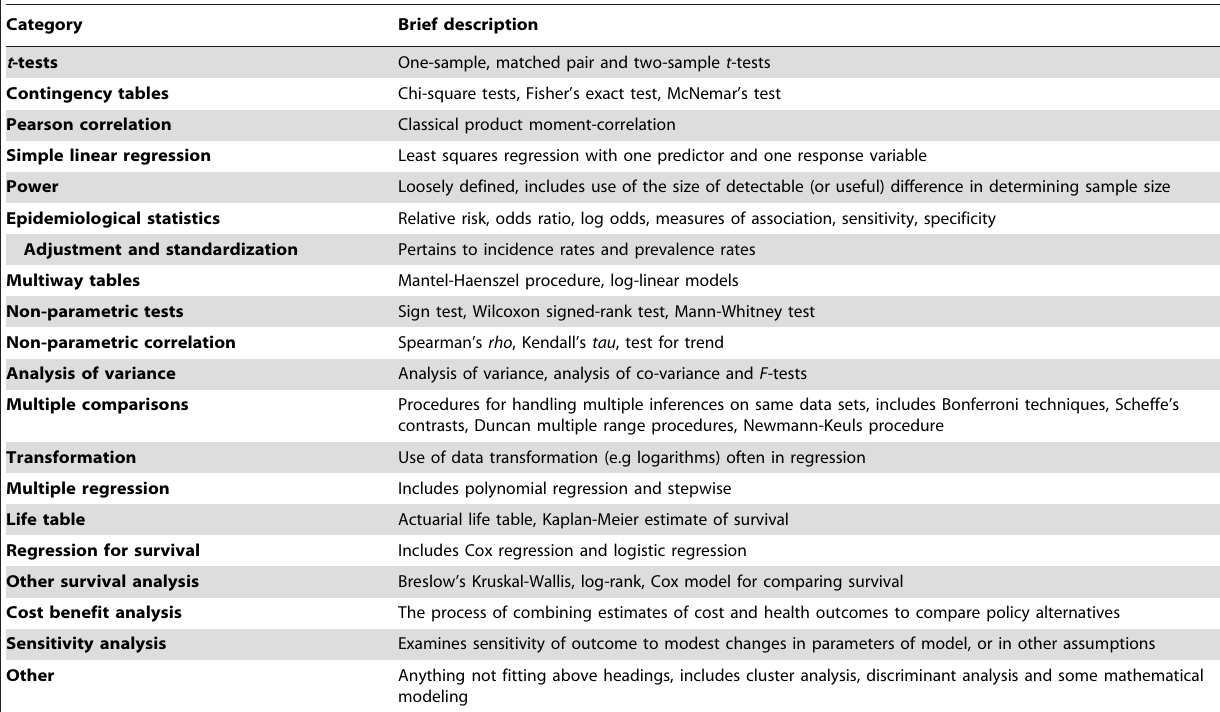
Table 1. Classification of statistical methods as reported in